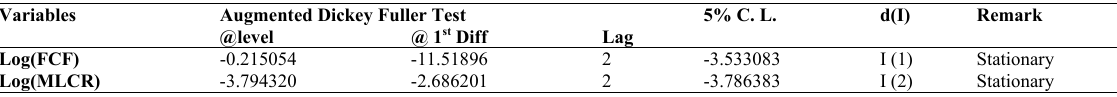
Unit root test result using ADF procedure for the